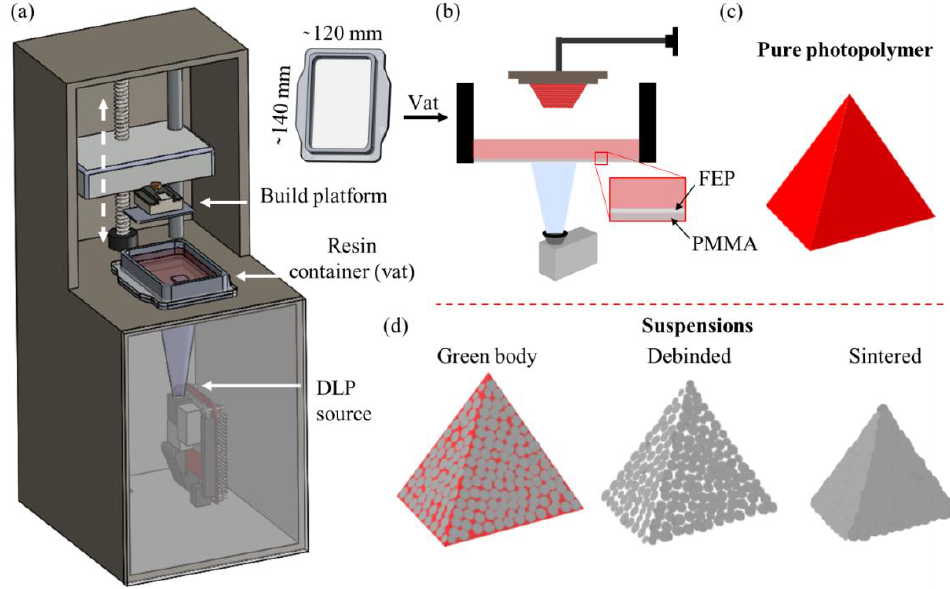
Figure 1. CAD model ( a ) and schematic ( b ) of a bottom-up DLP printer enabling the manufacturing of 3D objects from pure photopolymers ( c ) and suspensions followed by debinding, for thermal decomposition and removal of photopolymer, and sintering, for powder consolidation ( d ).